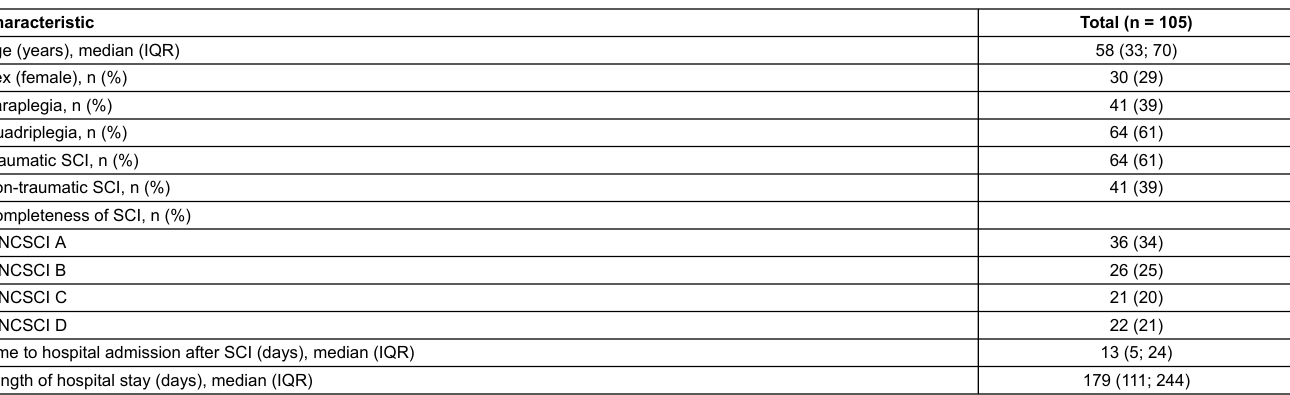
Table 1: Baseline